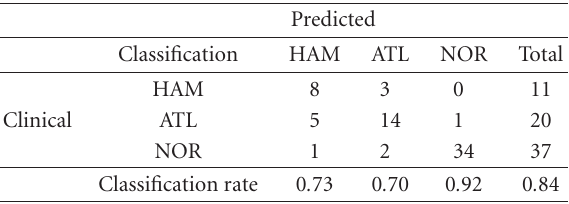
Table 1. Confusion matrix to show the performance of δ B using Diana.